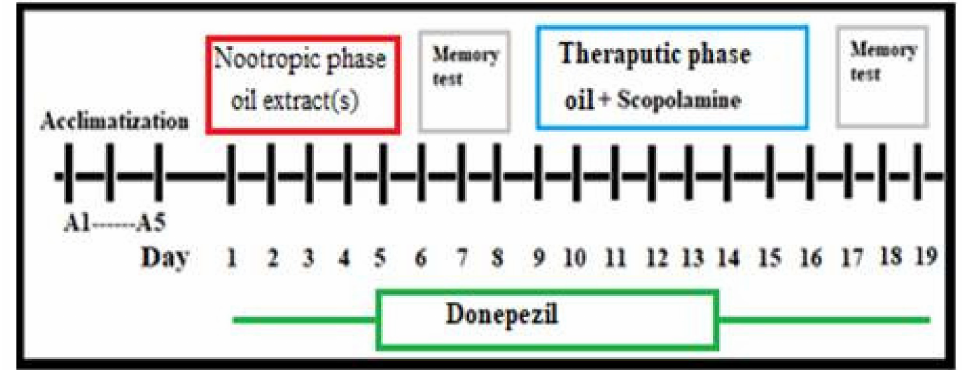
Figure 1. Schematic diagram of experimental procedure; nootropic phase and therapeutic phase